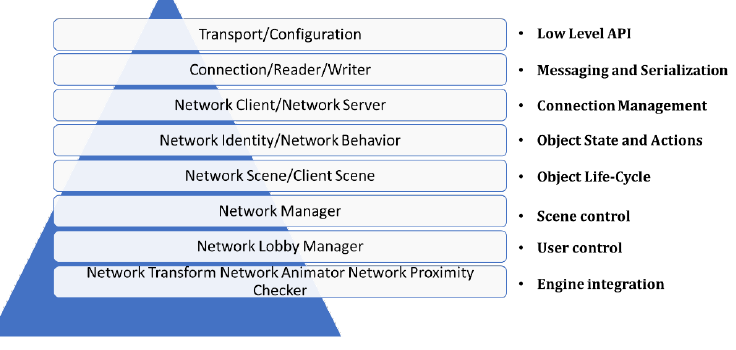
Figure 5. Functionalities per Layer of Unity 3D UNet API.